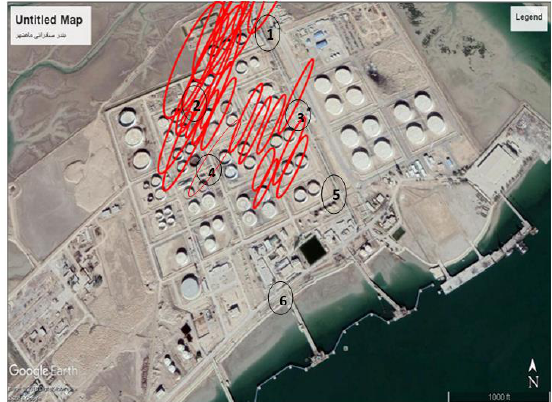
Fig. 4. VOC emissions from storage tanks in cold season and selected points for field